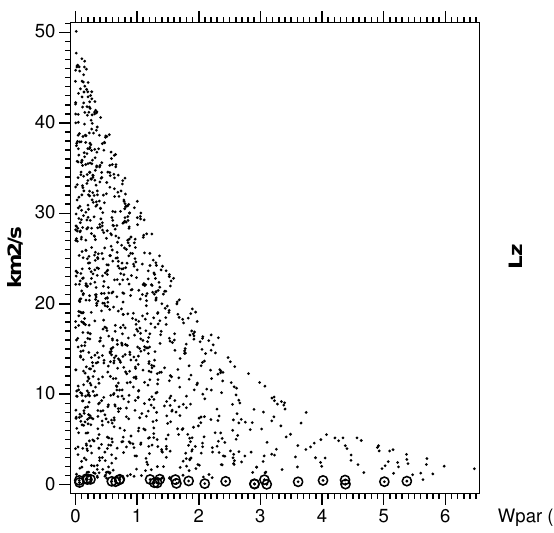
Fig. 9. Scatter plot of particle’s parallel kinetic energy W angular momentum L z in the test particle